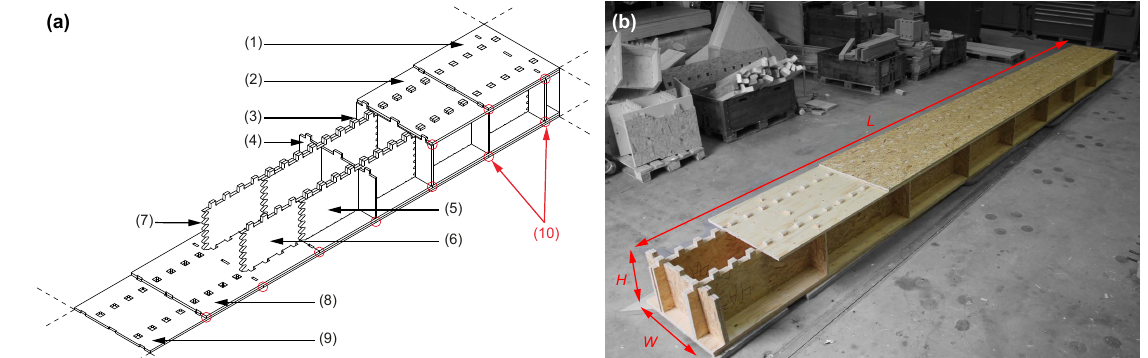
Figure 1. ( a ) Developed construction system: (1) top flange exterior layer, (2) top flange interior layer, (3) through tenon (TT) connection, (4) transversal beam, (5) web first layer, (6) web second layer, (7) longitudinal connection for web, (8) bottom flange interior layer, (9) bottom flange exterior layer, (10) discontinuities due to panel sizes. ( b ) Picture of one specimen produced in the